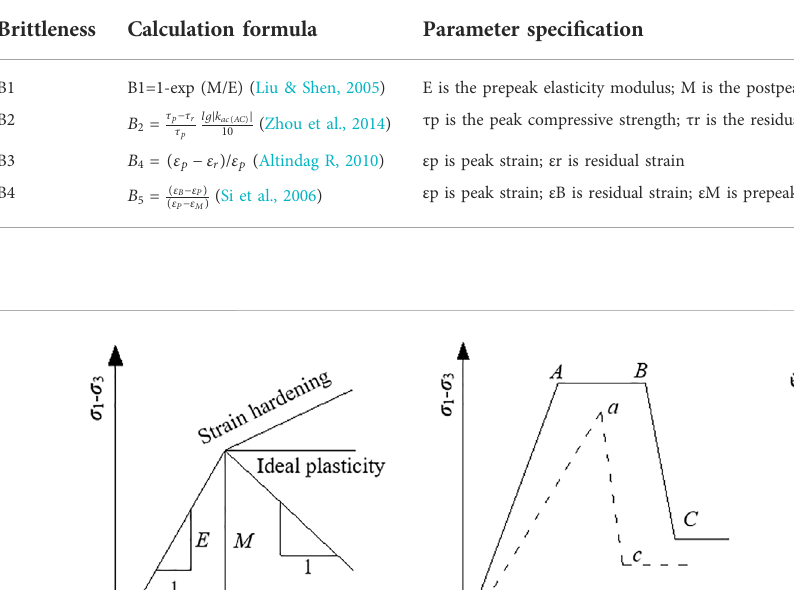
TABLE 2 Brittleness indices for comparative analysis.